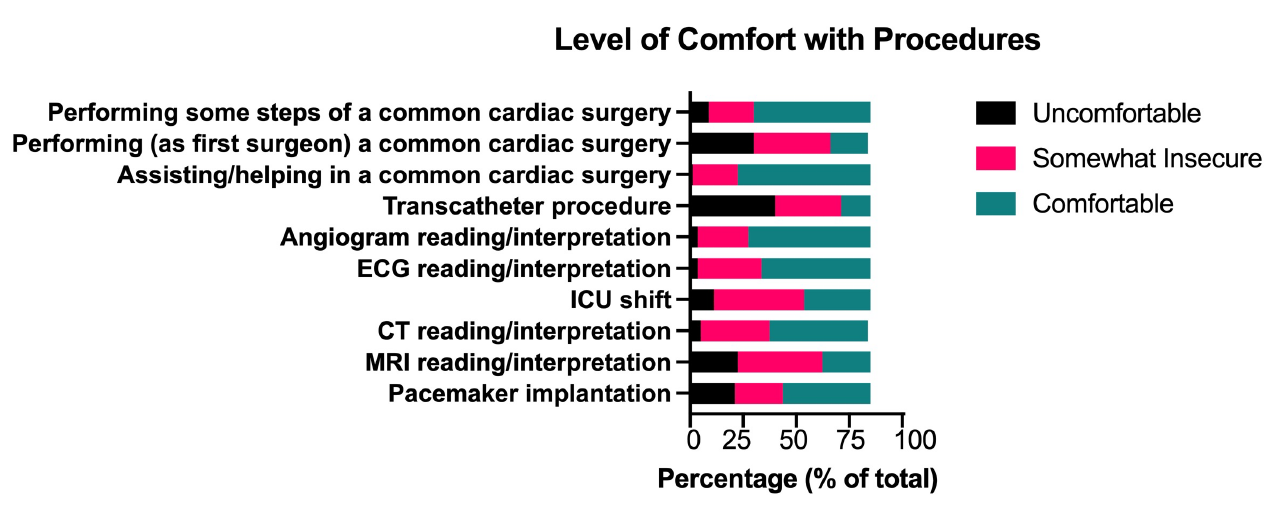
Fig. 3 - Residents’ and fellows’ level of comfort in performing procedures. CT=computed tomography; ECG=electrocardiogram; ICU=intensive care unit; MRI=magnetic resonance